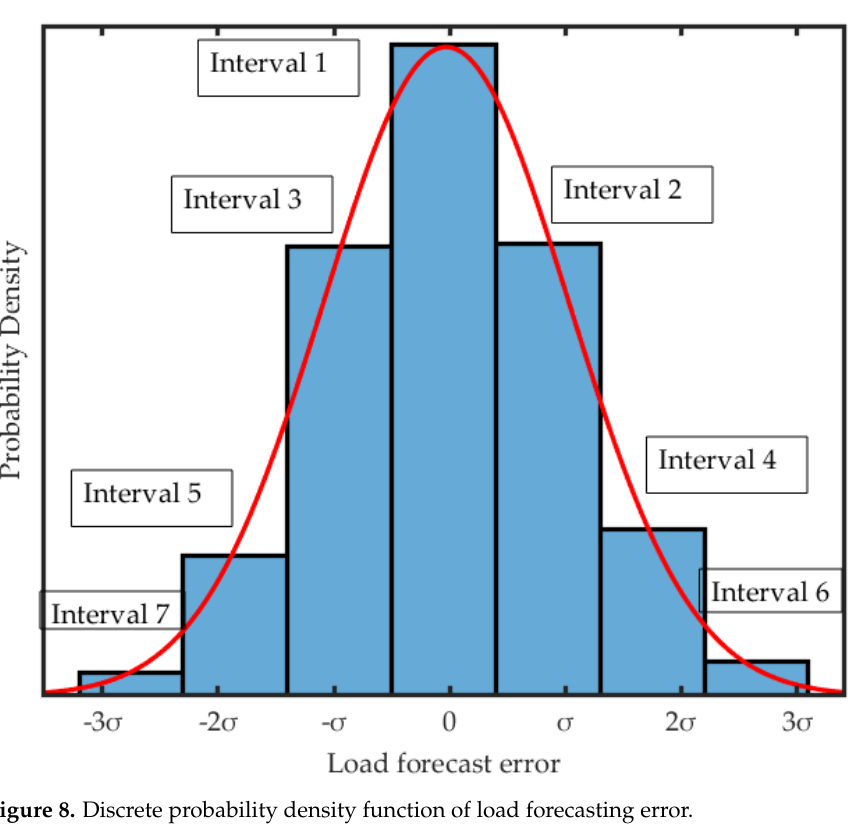
Figure 8. Discrete probability density function of load forecasting error.